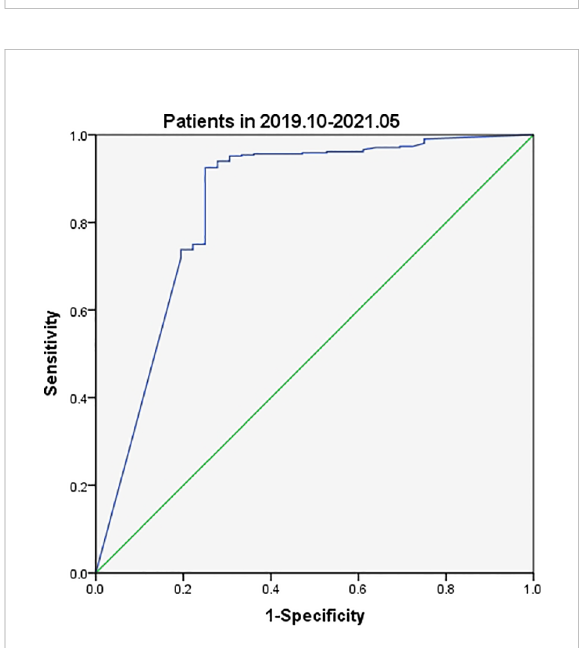
FIGURE 4 The ROC curves of FNA-Tg in different assay kits of Tg (Patients in